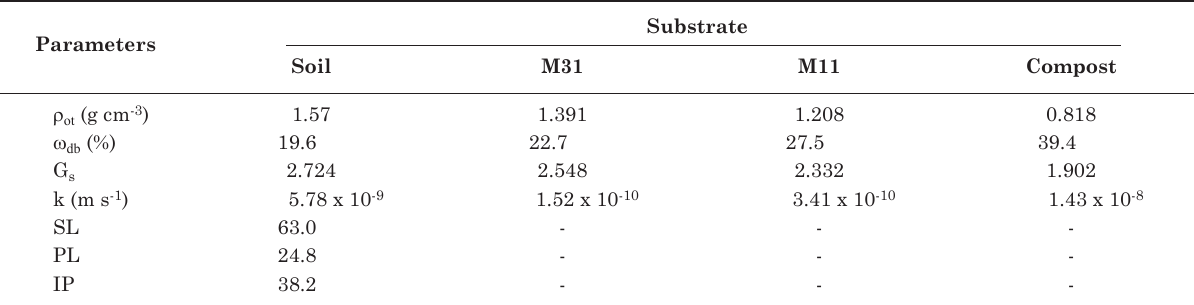
table 4. Geotechnical properties of the biofilters. m31 = 3:1 soil-compost mixture and m11 = 1:1soil- compost mixture